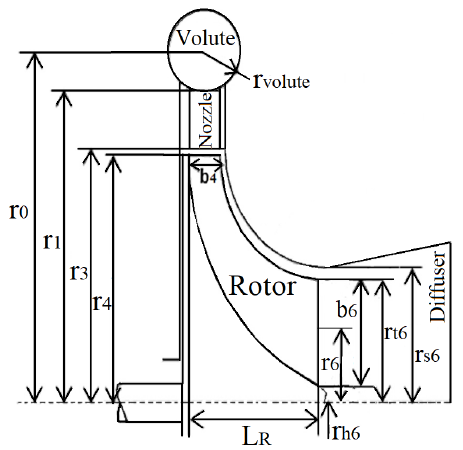
Figure 2. Meridional view of the radial inflow turbine, indicating different components and main dimensions, adapted from [41].